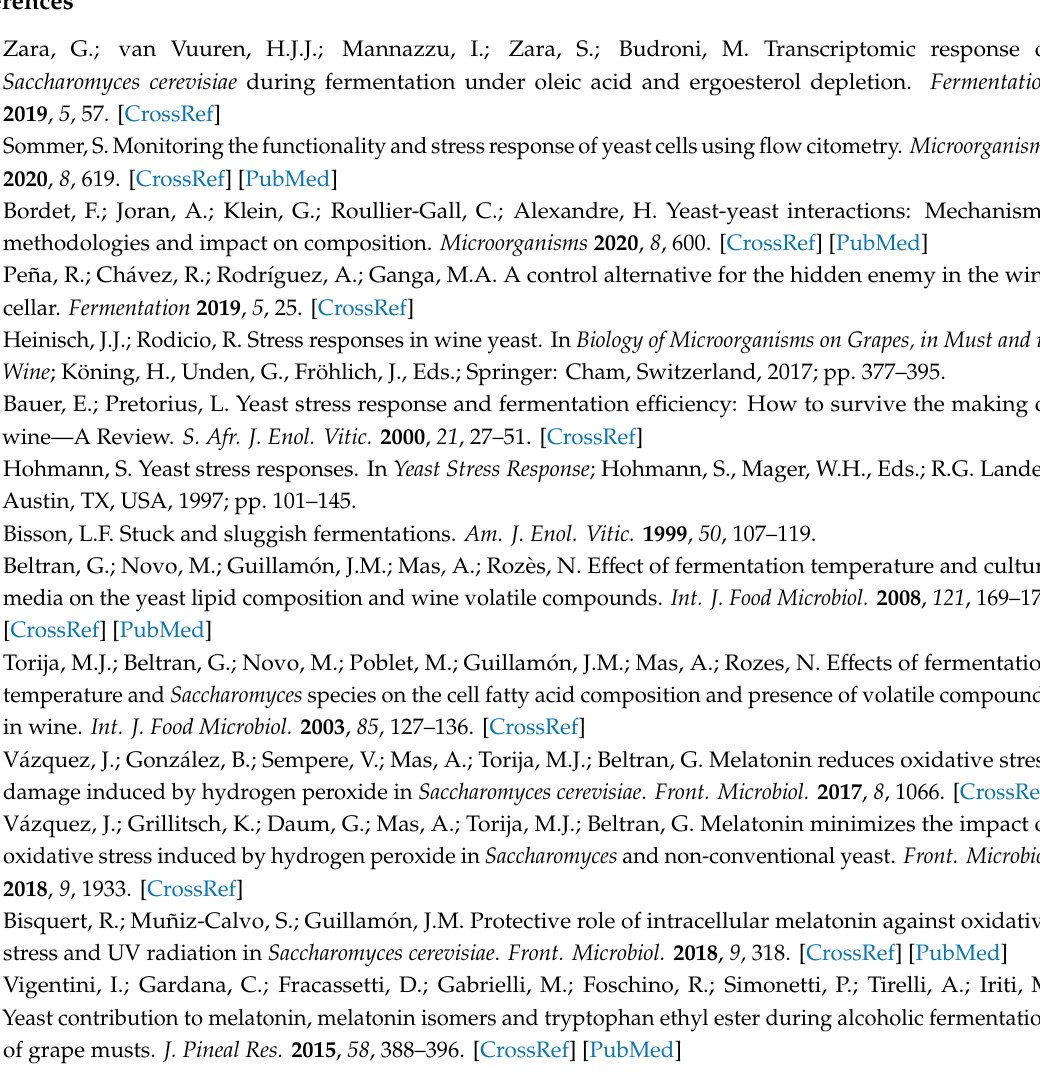
and -nitrogen grape must, Table S3: E ff ect of low temperature and inoculum size on intracellular melatonin production by S. cerevisiae QA23, Table S4: Comparison of intracellular melatonin production by arrested and non-arrested yeast cells, Table S5: Analysis of di ff erences between intracellular melatonin synthesis by di ff erent Saccharomyces strains, Table S6: Analysis of di ff erences between intracellular melatonin synthesis profile by di ff erent Saccharomyces strains, Table S7: Analysis of di ff erences between extracellular melatonin synthesis by di ff erent Saccharomyces strains, Table S8: Analysis of di ff erences between extracellular melatonin synthesis profile by di ff erent Saccharomyces strains, Table S9: Analysis of di ff erences between intracellular melatonin synthesis on di ff erent conditions, Table S10: Analysis of di ff erences between intracellular melatonin synthesis profile on di ff erent